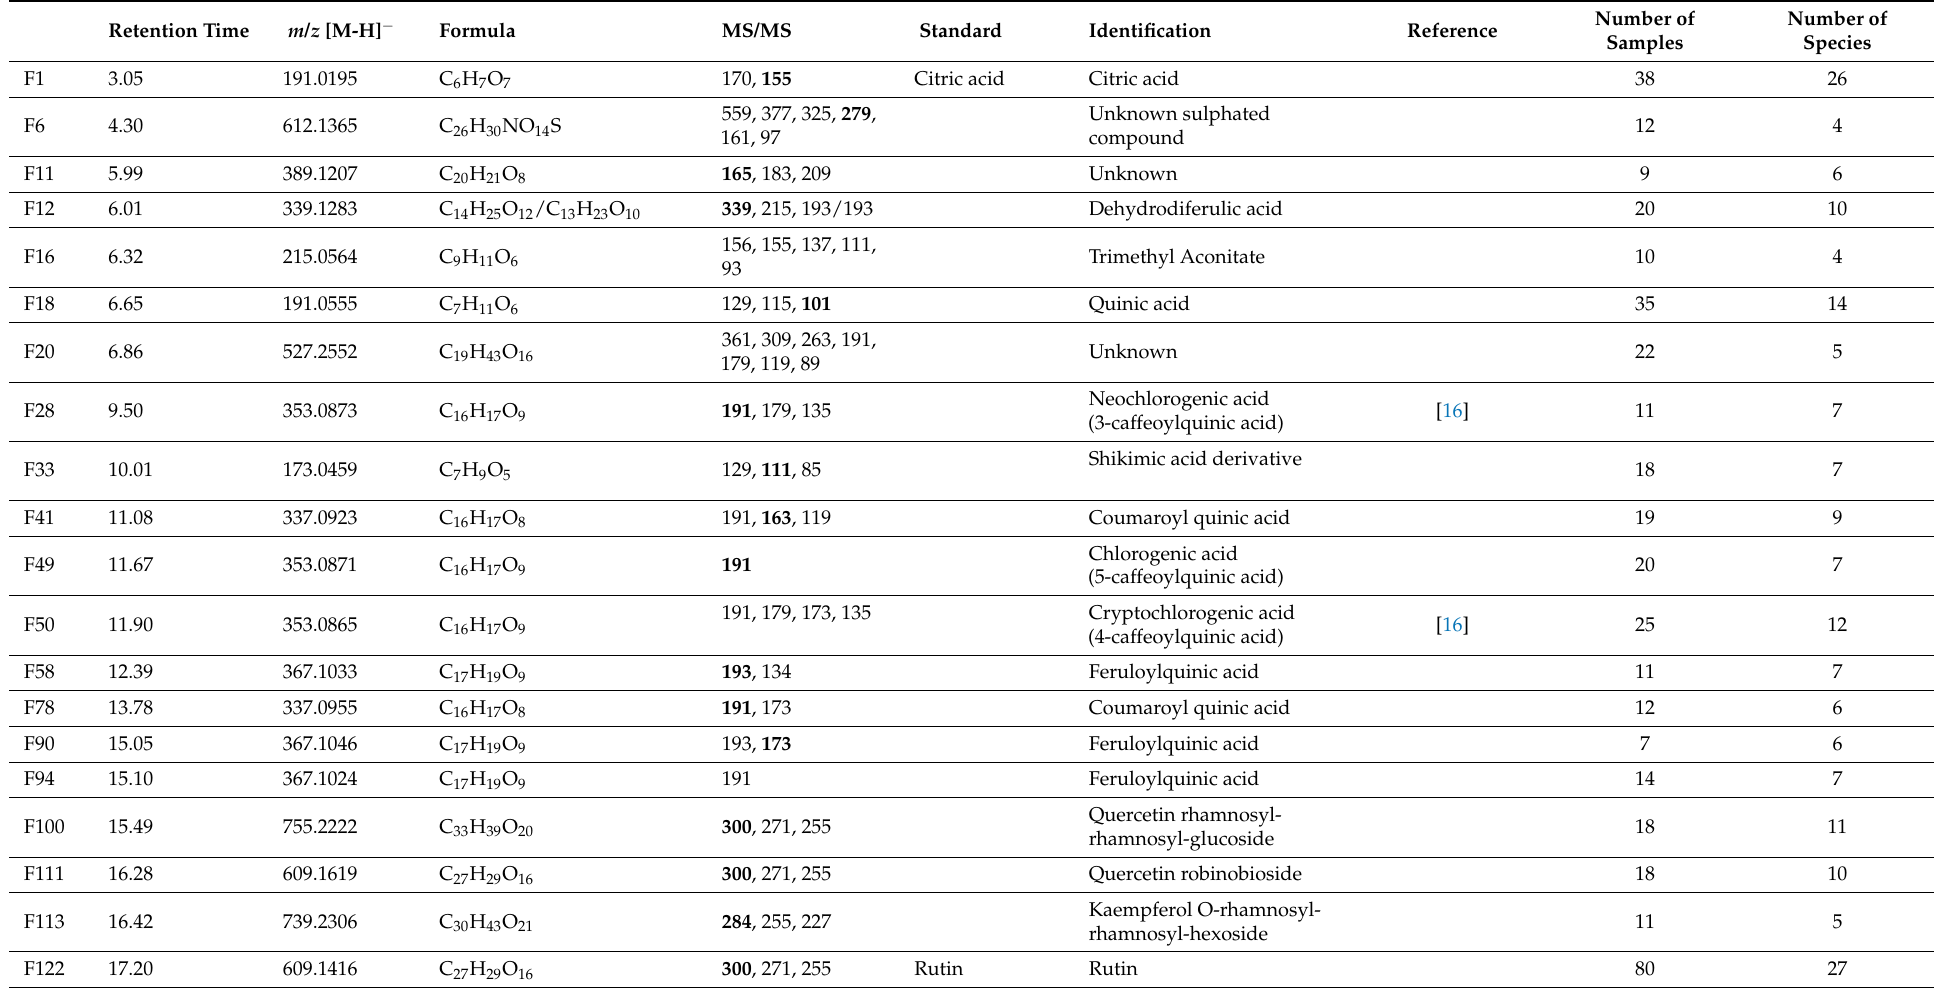
Table 2. The most common phenolic compounds and organic acids (peaks) detected in a total of 156 samples from 50 species of Thesium , along with their retention time, molecular mass, molecular formula, fragments, standards used and preliminary identifications with associated references. The number of samples and species in which each compound was observed at high levels (peak intensity > 30%) are also